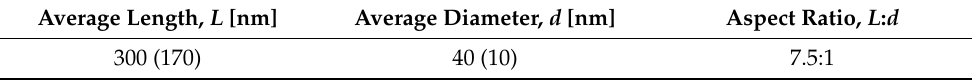
Figure 1. FE-SEM micrograph of dilute suspension of chitin nanoparticles in water. Table 2. Dimensional properties of chitin nanoparticles (values in brackets correspond to the stan- dard